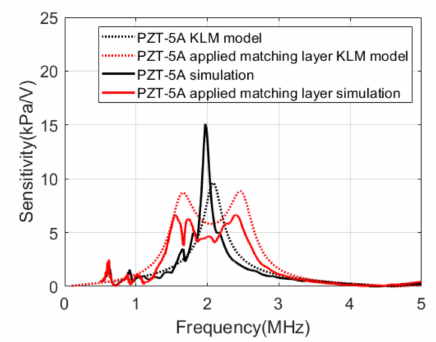
Figure 6. Transmit sensitivities of the Krimholtz, Leedom, and Matthaei (KLM) models and the